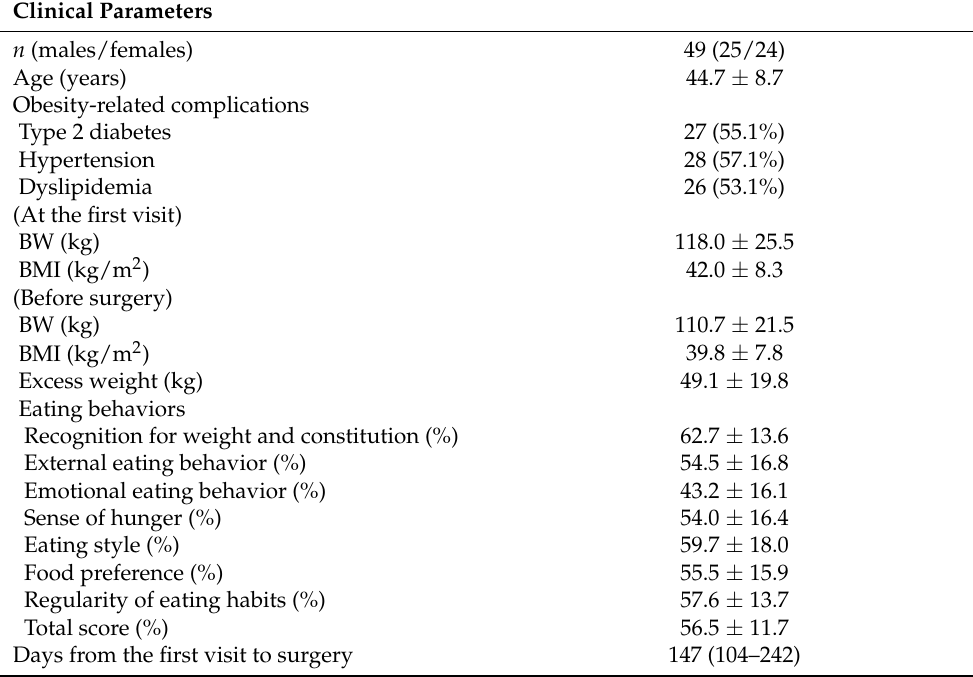
Table 1. Clinical characteristics of the study